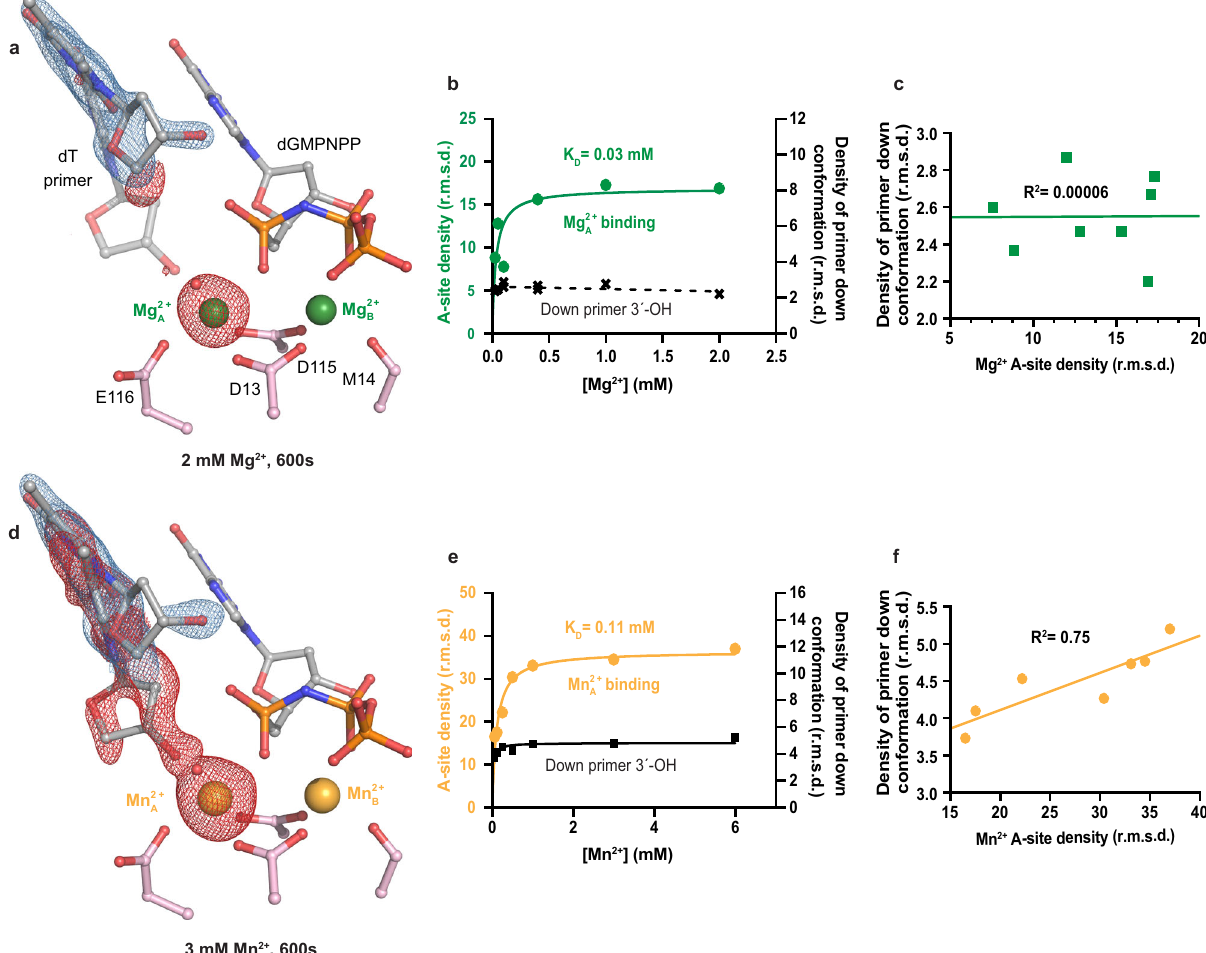
Fig. 5 Titration of the Me 2 + A on primer 3 ′ -OH alignment. a Structure of Pol η :dGMPNPP with 2.0 mM Mg 2 + . b Plot showing Mg 2 + A density and omit map electron density for the down primer with Mg 2 + concentration. c Correlation ( R 2 ) between the Mg 2 + A density and omit map electron density for the down primer. d Structure of Pol η :dGMPNPP with 3.0 mM Mn 2 + . e Plot showing Mn 2 + A density and omit map electron density for the down primer with Mn 2 + concentration. f Correlation ( R 2 ) between the Mn 2 + A density and omit map electron density for the down primer conformation. The 2F o -F c map for the primer up conformation (blue) was contoured at 2 σ in ( a ) and 1.5 σ in ( d ). The F o -F c omit map for both the Me 2 + A and primer down conformation (red) were contoured at 3 σ . All data points shown in the plot were collected at t = 600 s and represent singular measurements.